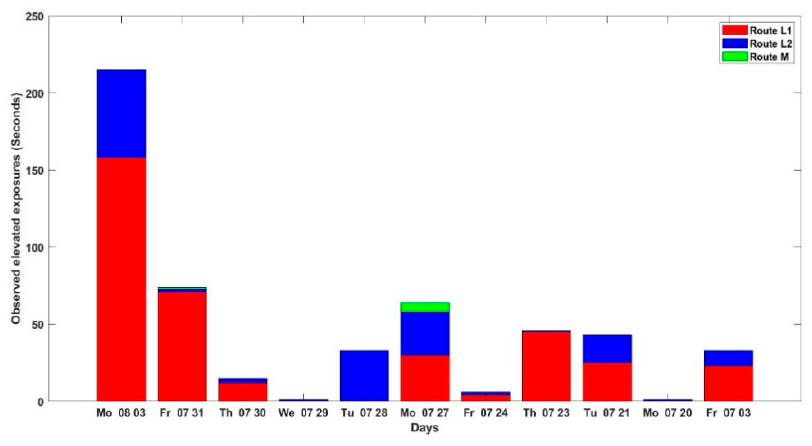
Figure 7. Number of elevated concentration (in seconds) per day.